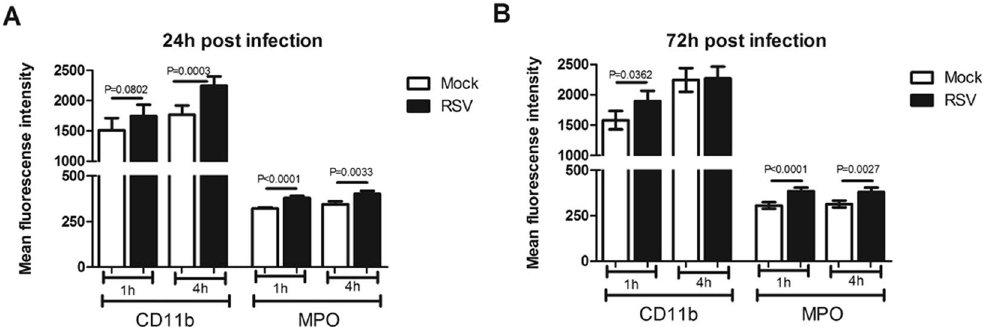
Figure 4. Neutrophil migration through RSV infected monolayers show increased cell surface expression of CD11B and MPO. Neutrophils that migrated through RSV infected epithelial cells infected for (A) 24 hours or (B) 72 hours showed higher cell surface expression of CD11B and MPO compared to those that migrated through mock-infected epithelial cells. Neutrophils were collected from the apical compartments and the percentage stained for cell surface expression of CD11B (PE) and MPO (APC) were determined by flow cytometry. Neutrophils were gated on initially using a PE positive gate. Using this population the geometric mean fluorescence intensity of PE and APC fluorescence was calculated. Neutrophils from the same donor were compared. Bars show mean ± SEM of n = 4 biological repeats. Statistical significance is shown. For all other comparisons P > 0.05.